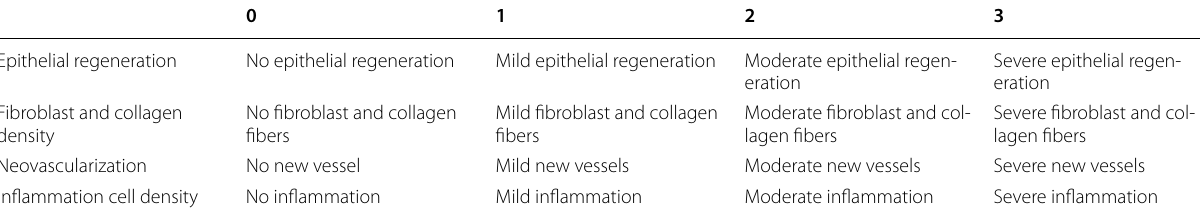
Table 2 Semi-quantitative scoring between groups of epithelial regeneration, fibroblast cells, collagen fibers, neovascularization, and inflammatory cell density in the lamina propria layer after tympanic membrane lesion